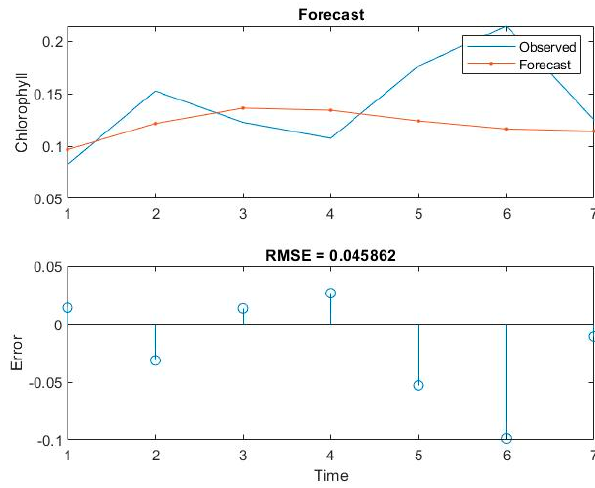
Figure 10. Training curve for the LSTM.